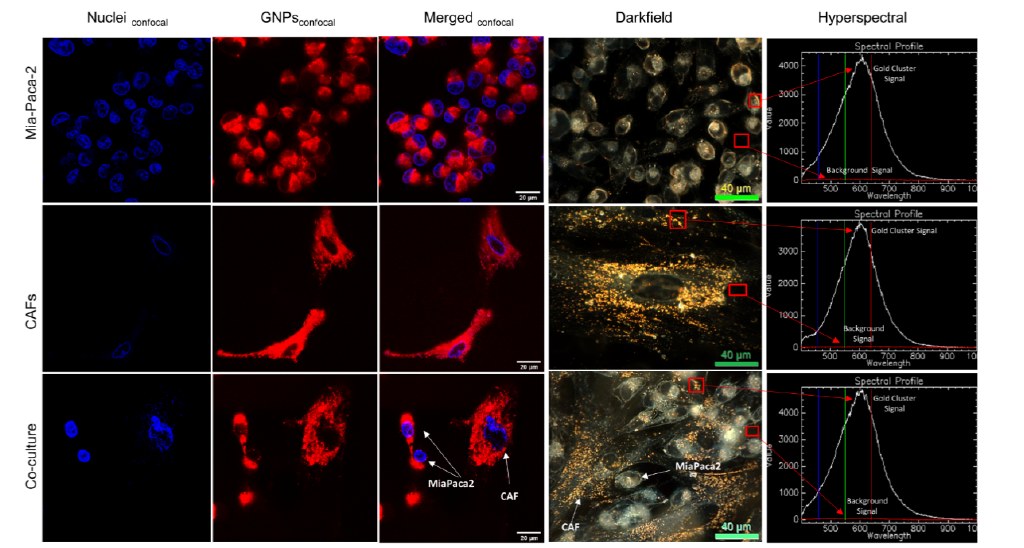
Figure 4. Gold nanoparticles (GNPs) uptake in cancer cells and CAFs in monoculture vs. co-culture. GNP distribution in monoculture MIA PaCa-2 (first row), monoculture CAFs (second row), and co-culture of CAFs & MIA PaCa-2with 2:1 ratio (third row), using confocal imaging in the first three columns, where the first column shows the nucleus in blue, the second column shows GNPs in red, the third column shows both merged, using darkfield microscopy (fourth column), and using hyperspectral imaging (HSI; fifth column) which shows a spectrum collected from GNP clusters (white spectrum) vs. background (red spectrum). Scale bars are 20 µm and 40 µm for confocal and DF, respectively.